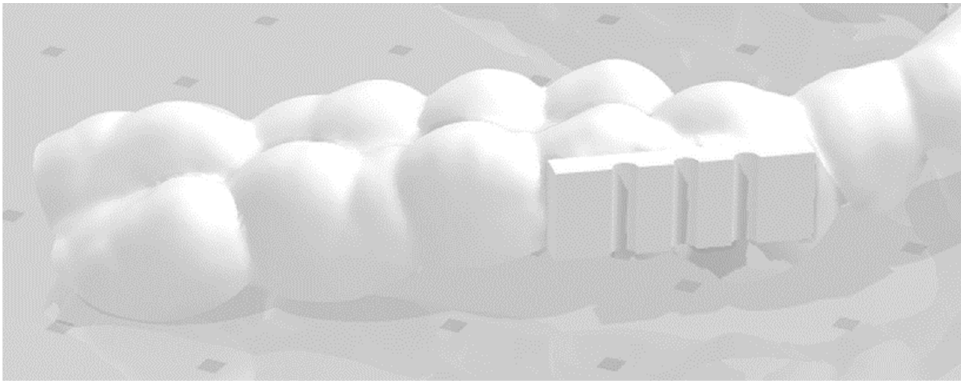
Figure 1. The scanned CAD/CAM manufactured mouth guard, the attachment exhibiting both curved and rectilinear contours and positive and negative relief with regular and irregular multiple concavities and convexities.